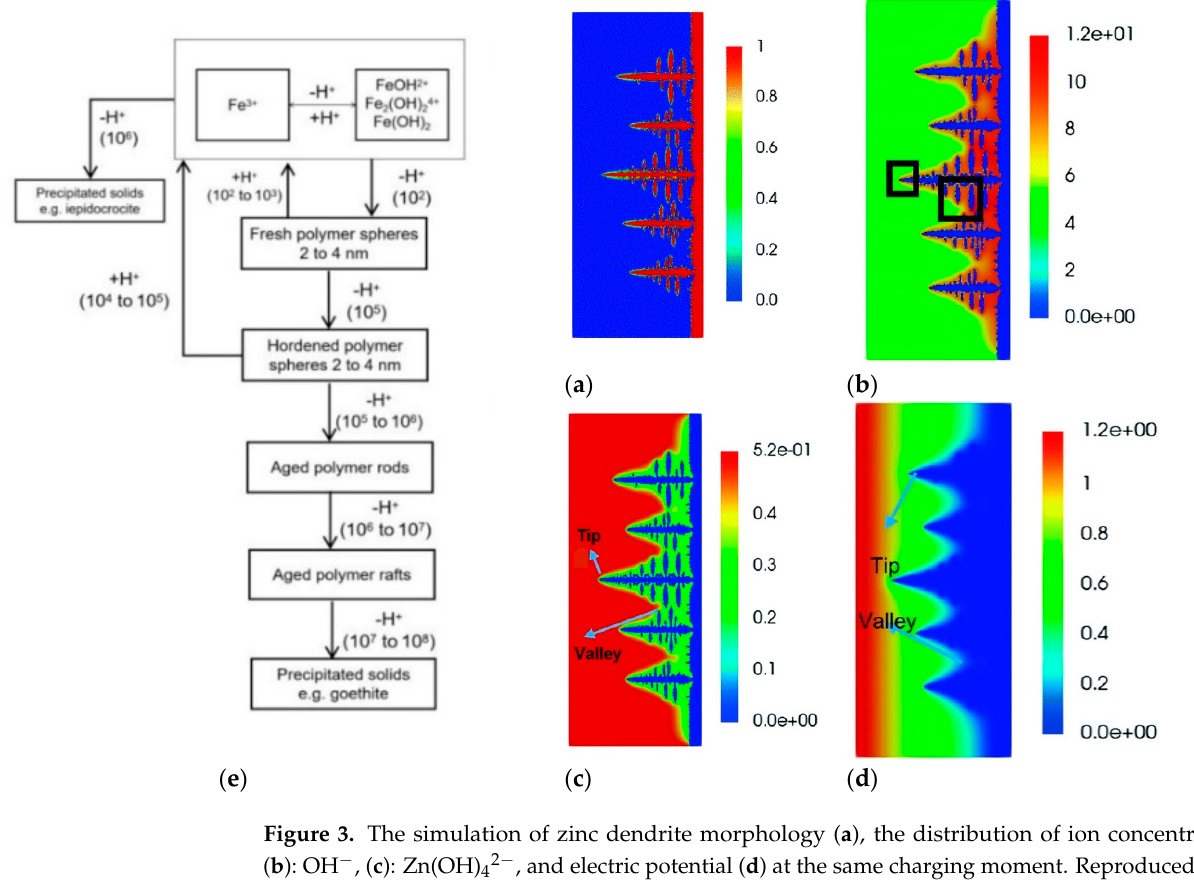
Figure 3. The simulation of zinc dendrite morphology ( a ), the distribution of ion concentration ( b ): OH − , ( c ): Zn(OH) 42 − , and electric potential ( d ) at the same charging moment. Reproduced with permission from [78]. Copyright 2021, Royal Society of Chemistry. ( e ) Hydrolysis processes in Fe(III) solutions (numbers in parentheses give reaction times (s) at 25 °C). Reproduced with permission from [79]. Copyright 1984, American Chemical Society.